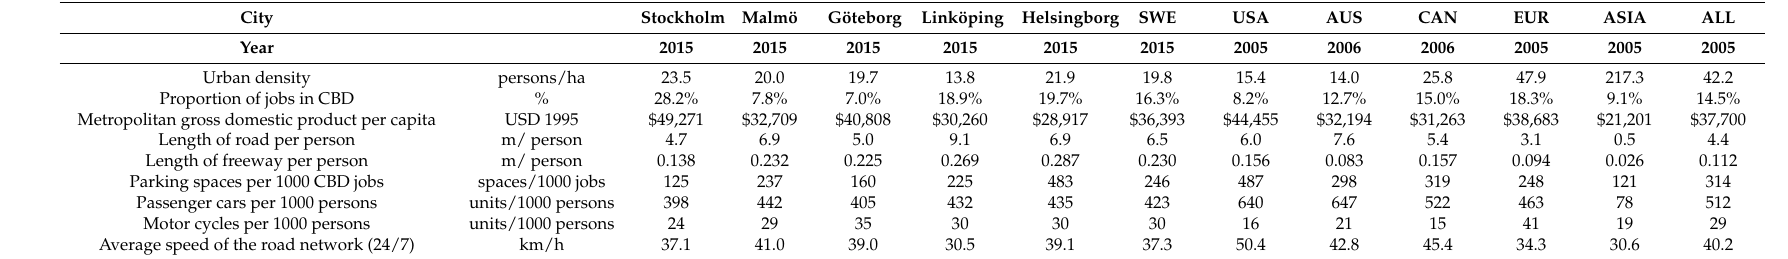
Table 4. Land use, GDP, and private transport infrastructure characteristics of Swedish and international cities City Stockholm Malmö Göteborg Linköping Helsingborg SWE